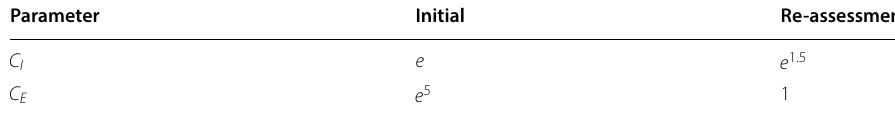
Table 13 Pattern measure constants (of Step 2) for GCH Parameter Initial Re‑assessment